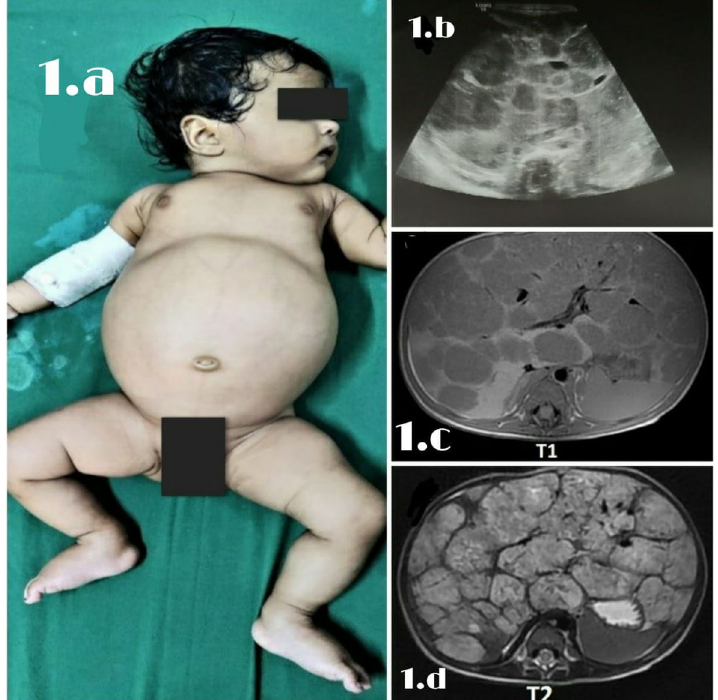
Fig. 1 a Clinical image of the index case before treatment. b Ultrasound abdomen image of index case before treatment. c T1W CE MRI image showing nodular hepatic lesions. d T2W CE MRI image showing hyperintense nodular hepatic